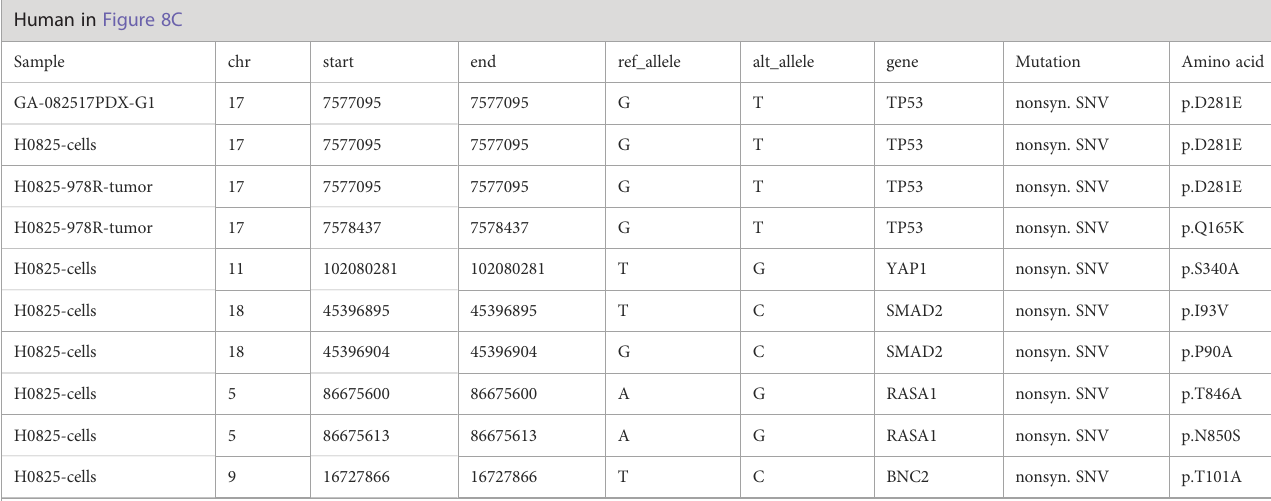
TABLE 3 Somatic mutation list of WES analyses in GA082517-PDX-G1-derived human H0825 cells, murine M0825, P0825 cells, and their direct PDX tumors corresponding to Figures 6C , D